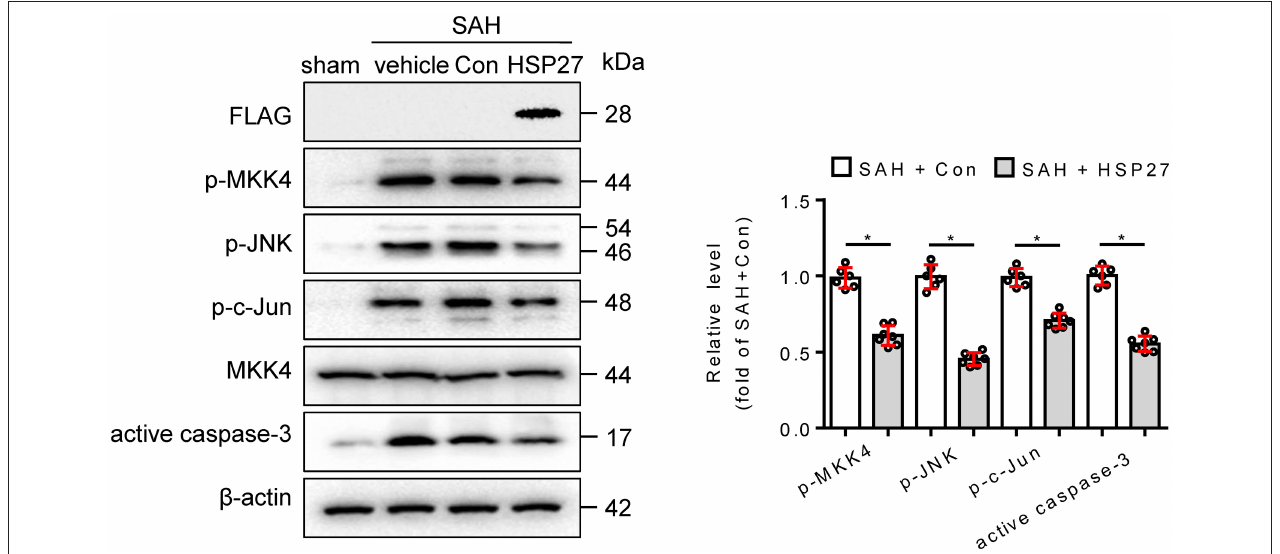
FIGURE 6 | Effect of HSP27 overexpression on the activation of MKK4, JNK, c-Jun, and caspase-3 on day 2 after SAH. The basal cortex was collected on day 2 following SAH from the sham ( n = 6), SAH + vehicle ( n = 6), SAH + Con ( n = 6), and SAH + HSP27 ( n = 7) groups; homogenates were blotted with anti-FLAG, anti-phospho-MKK4, anti-phospho-JNK, anti-phospho-c-Jun, anti-MKK4, anti-active caspase-3, and anti- β -actin; and quantification of optical density was normalized to sham group. Data are mean ± SD, * p < 0.05, the two-tailed t -test.